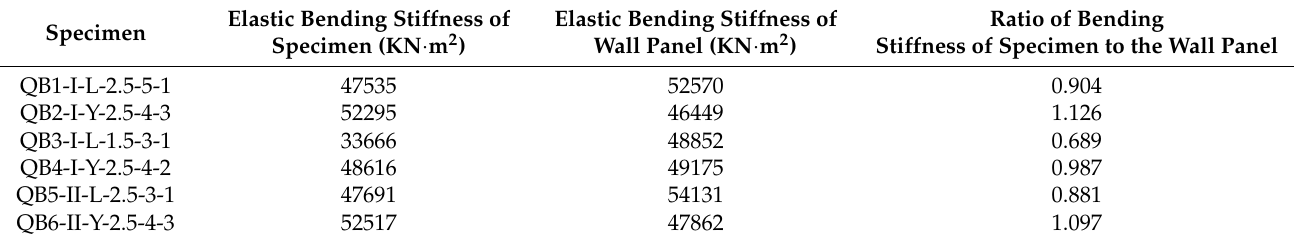
Table 6. Elastic bending stiffness of specimens and wall